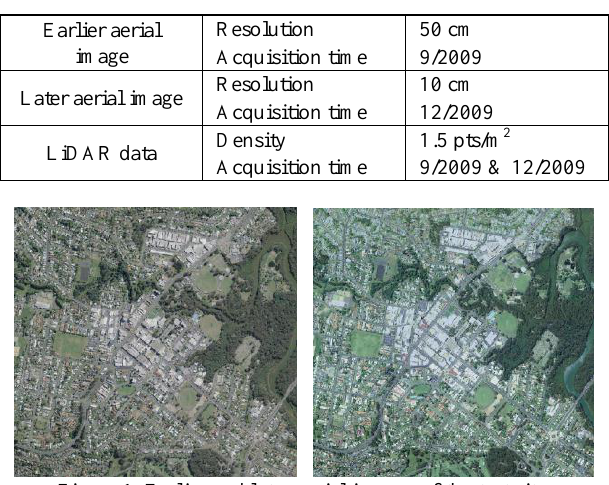
Figure 1. Earlier and later aerial images of the test